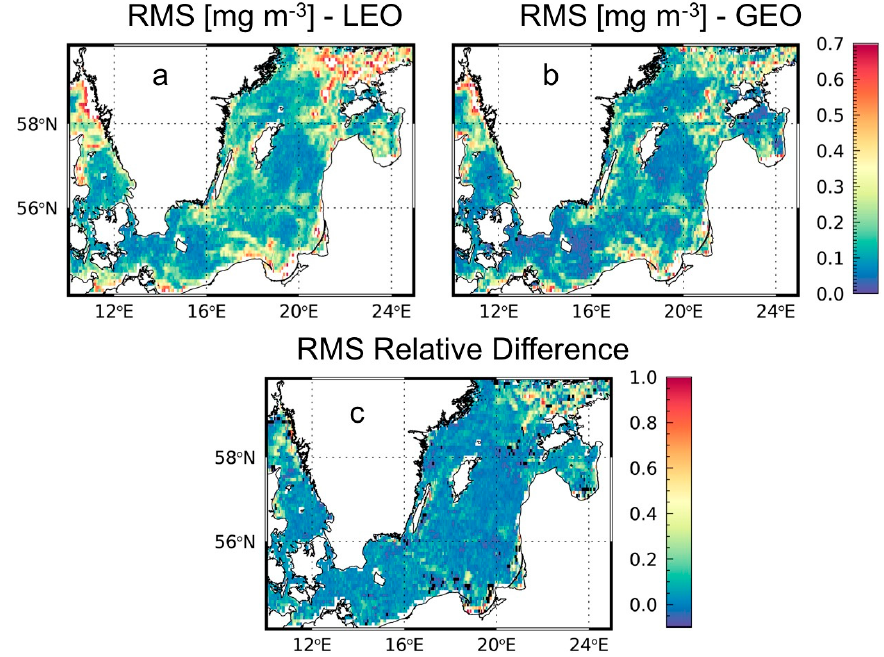
Figure 8. RMS reconstruction error for daily Chl field in case of LEO ( a ) and GEO ( b ) sensors. Panel ( c ) represents the relative differences between RMS of LEO and GEO.